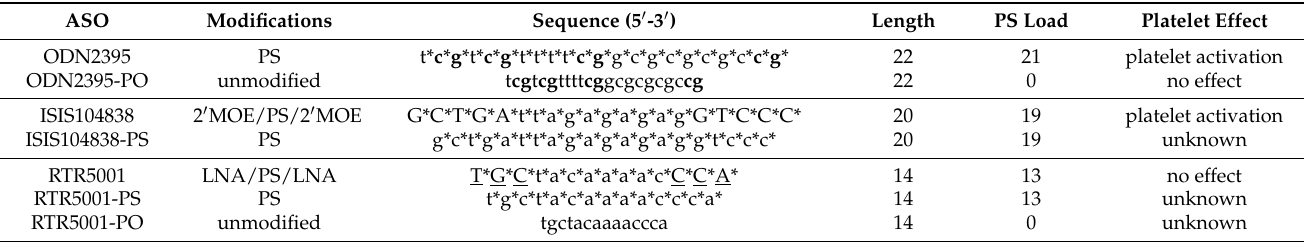
Table 1. Tool ASOs. Three ASO sequences with varying modifications were included in this study to investigate their effects in minipig